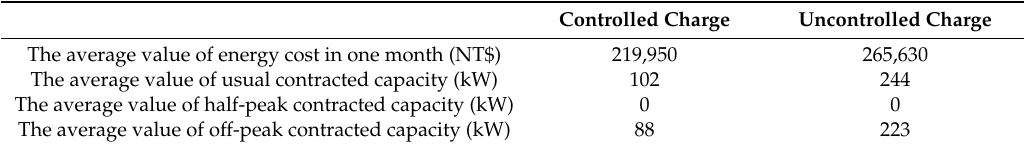
Table 5. Economic analysis parameters for the charging station.